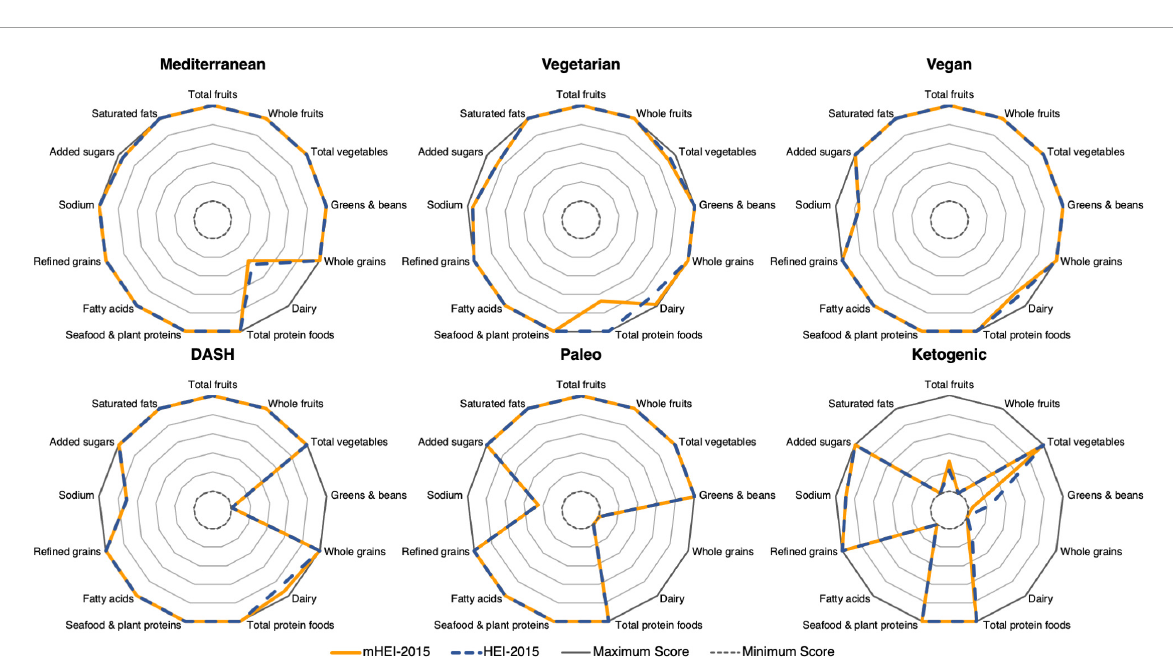
FIGURE4 Radar graphs of HEI-2015 and mHEI-2015 for six different dietary patterns. The HEI-2015 and mHEI-2015 lines indicate the percent compliance with the recommendation of the components. Overconsumption of individual components is not shown in the